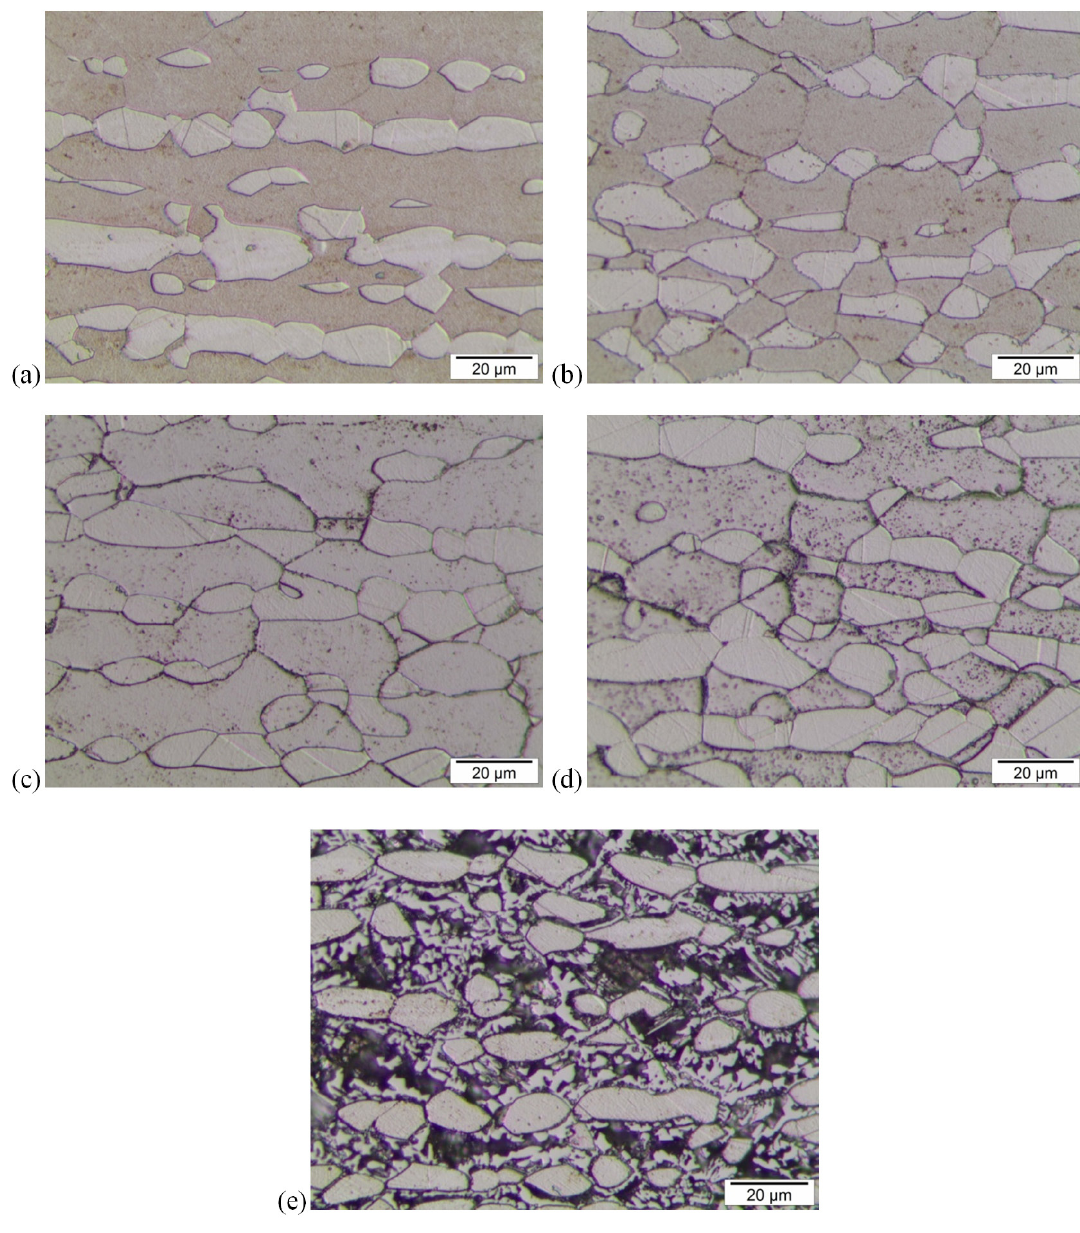
Figure 6. Optical micrographs of samples surfaces after DL-EPR tests. Solution treated sample (a) and samples aged at 650°C for (b) 20 min, (c) 1 h, (d) 4 h and (e) 360